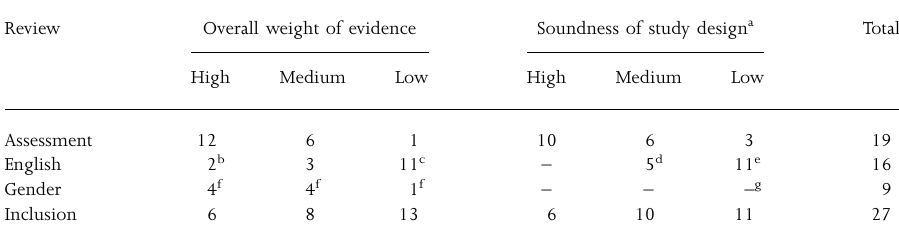
Table 3 Overall weight of evidence, and soundness of study design: studies included in the in-depth stages of the first four EPPI-Centre systematic reviews